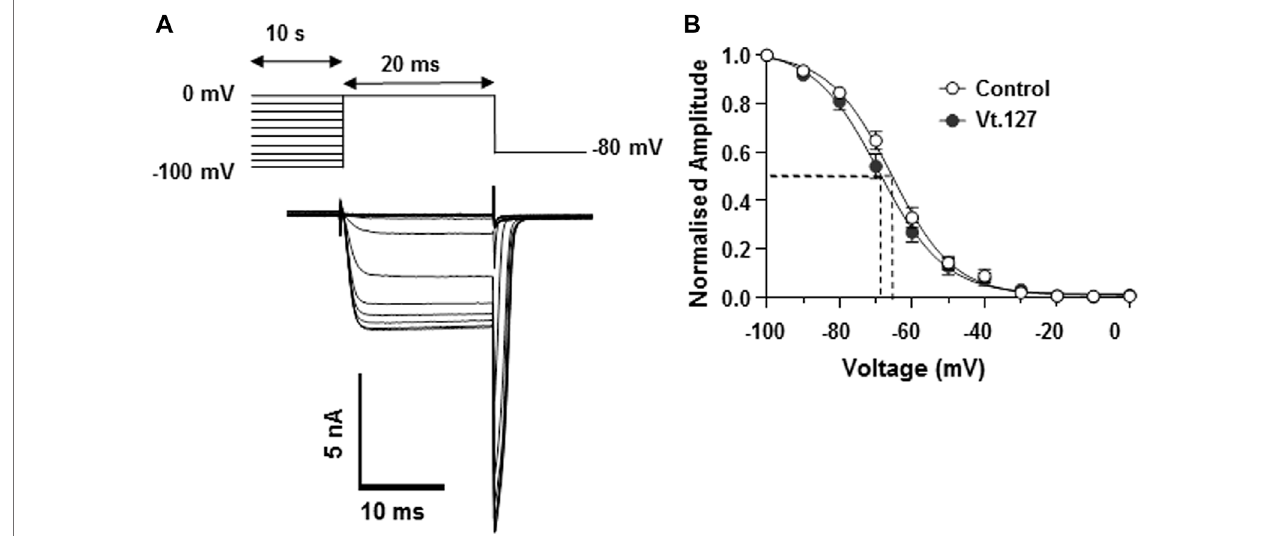
FIGURE 5 | Effects of Vt1.27 on steady-state inactivation of Cav2.2 channels expressed in HEK293T cells. (A) Pre-pulse potentials ( − 100 to 0 mV in 10 mV increments for 10 s) were applied prior to a test pulse (20 ms) determined from the peak current and repeated every 15 s from a holding potential of − 80 mV. Representative superimposed Ba 2+ current traces obtained from different holding potentials. (B) Currents normalized to the maximum current amplitude plotted as a function of holding potential. Data points were fi tted with a single Boltzmann function. Half-maximum inactivation (V 0.5, inact ) was shifted by 3 mV in the presence